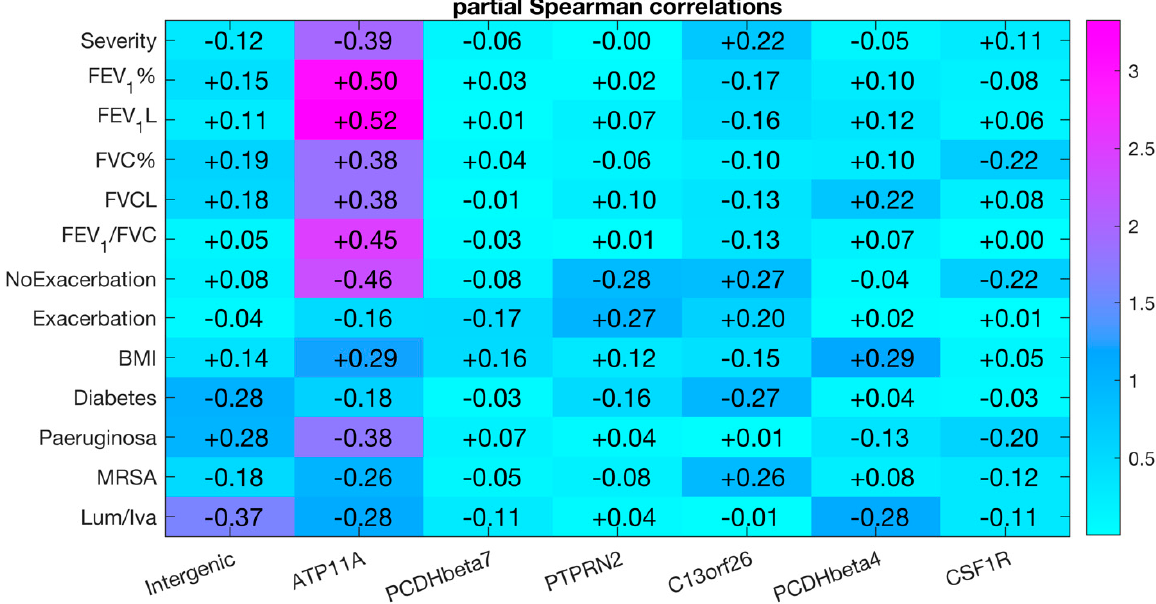
Figure 2. Age- and sex-adjusted Spearman correlations between DNA methylation at seven CpG sites and continuous or binary phenotypic traits of the MethylBiomark cohort. DNA methylation was measured by pyrosequencing in sputum samples collected at V1. Severity refers to the groups of mild, intermediate, or severe CF patients. NoExacerbation, number of exacerbations in 24 months after V1. Exacerbation, presence of exacerbation at V1. MRSA , methicillin-resistant Staphylococcus aureus . Lum/iva, lumacaftor/ivacaftor treatment. The color ladder represents minus the decimal logarithm of the p -value associated with the partial Spearman correlations.